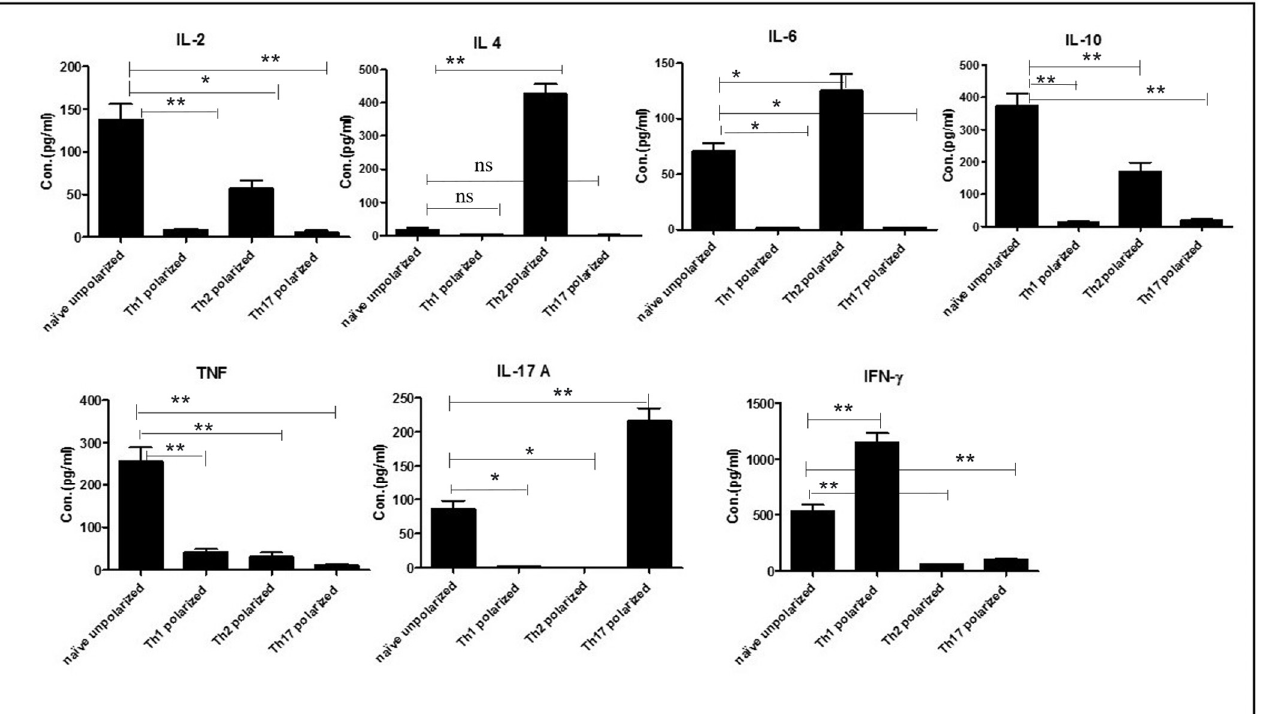
Figure 1. Naïve OT-II T cells were extracted from spleen and different lymph nodes of OT-II mice and these cells were cultured to polarize them, using OVA (20 μ g/mL) and differentiating cytokines and antibodies to cytokines. After washing, differentiated cells were stimulated with IL-7 for a further two days to produce memory cells. Finally, cells were stimulated with OVA (10 μ g/mL) for 72 h and further analysed using a cytokine bead array and flow cytometry to measure the concentration of cytokines secreted in culture supernatants. Single * ( p < 0.05) and double ** ( p < 0.01) in the graph represents the value statistical association among the dependent and independent variables and “ns” represents no statistical significance. The experiment in this study were performed in triplicates and the statistical association between different dependent and independent variables was analysed using t -test.